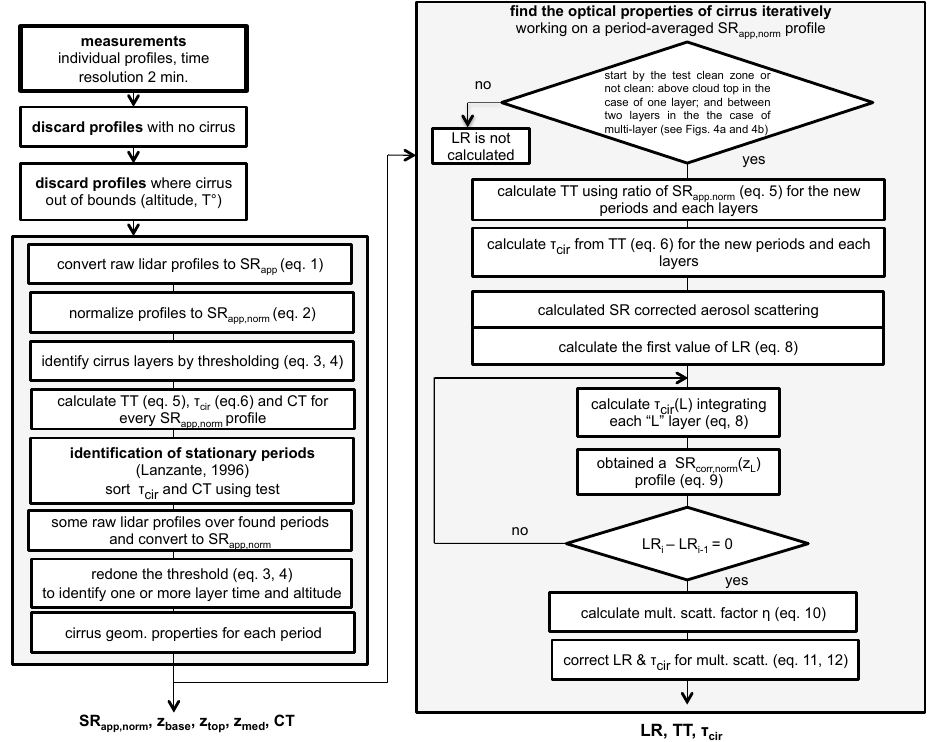
Fig. 7. Schematic flowchart showing the main steps of the methodology applied to obtain macrophysical and optical properties of cirrus